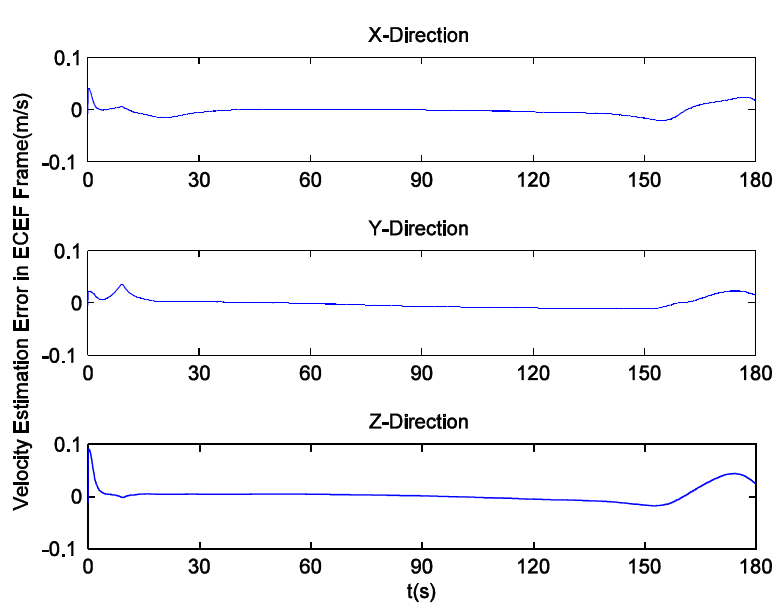
Figure 19. GPS/INS velocity estimation errors.